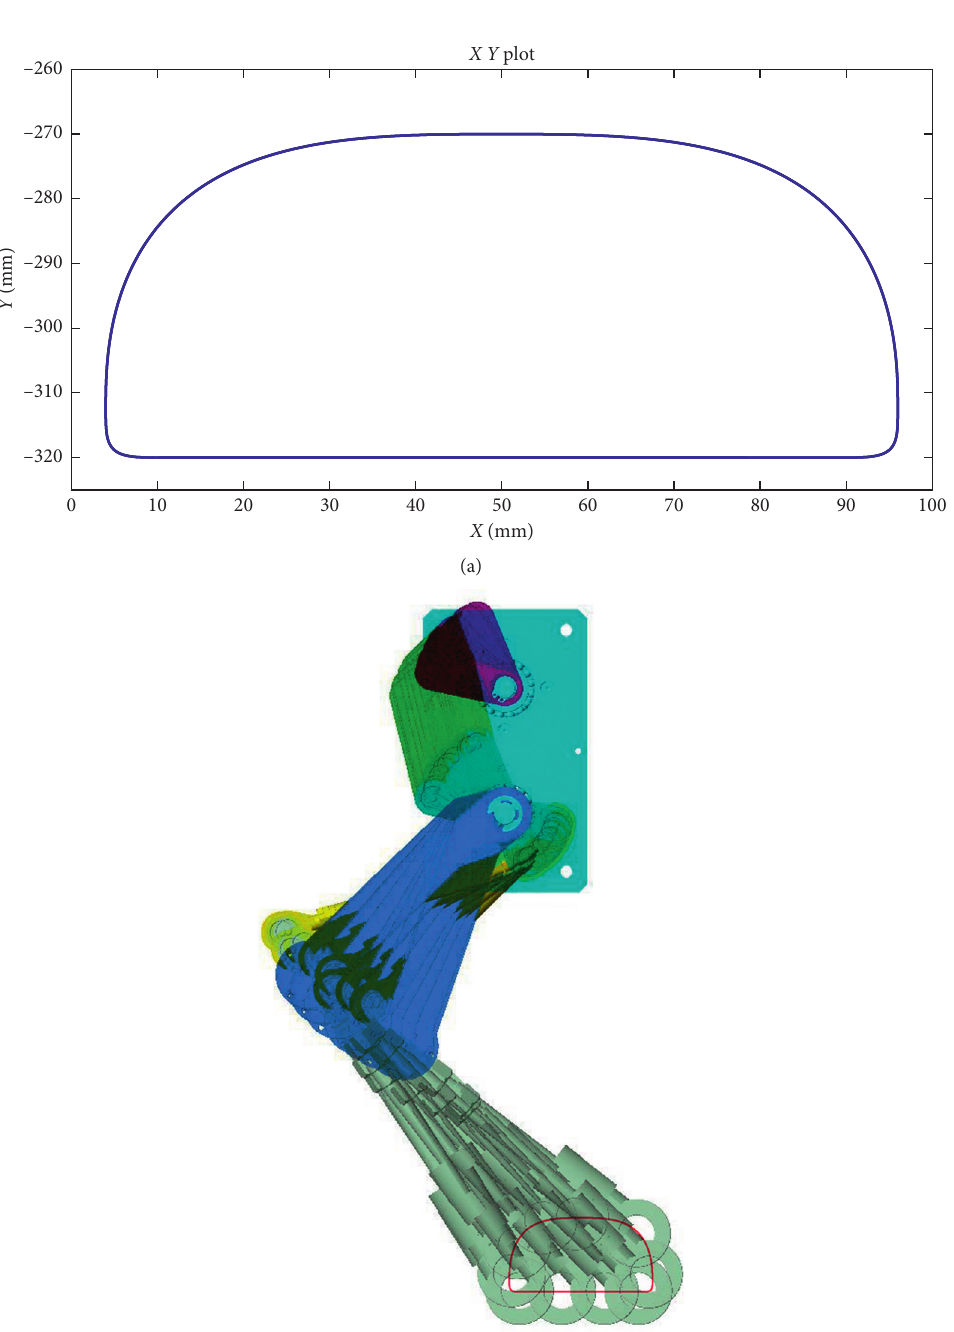
Figure 11: Modified trajectory: (a) curve and (b) cloud